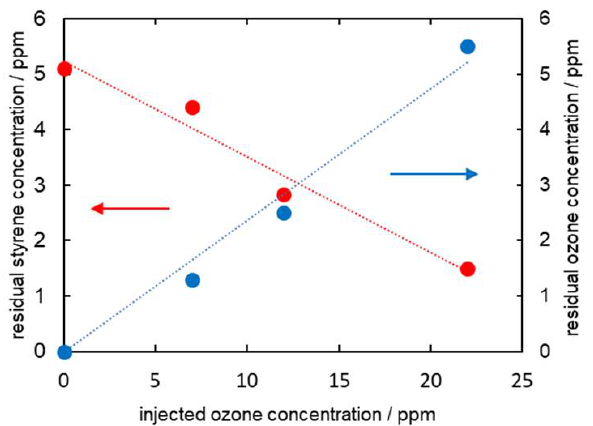
Figure 7. Relationship between injected ozone concentration and residual styrene (red), and ozone (blue) concentration on decomposition of styrene using photocatalyst and ozone treatment.